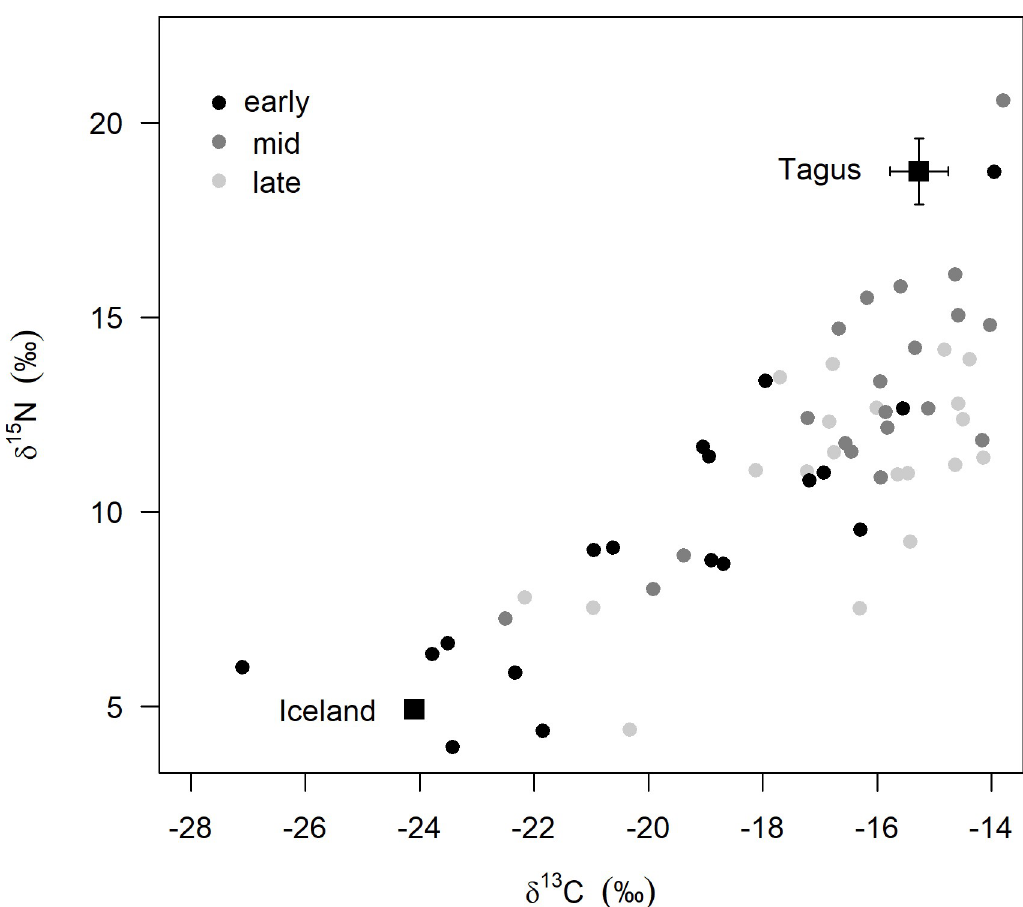
Fig 4. Carbon and nitrogen stable isotope signatures in red blood cells of dunlins sampled at the Tagus estuary during autumn migration. Early, mid and late correspond to three capture events (mid-July, early August and mid-August). Square symbols represent the expected signatures of dunlins (mean ± SD) at Iceland (obtained from chick feathers, n = 8) and Tagus estuary (obtained from overwintering birds during spring, n = 7).